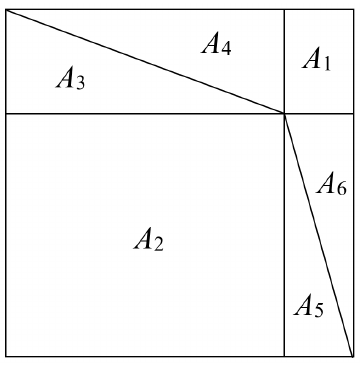
Figure 1. Diagram of (3) in Example